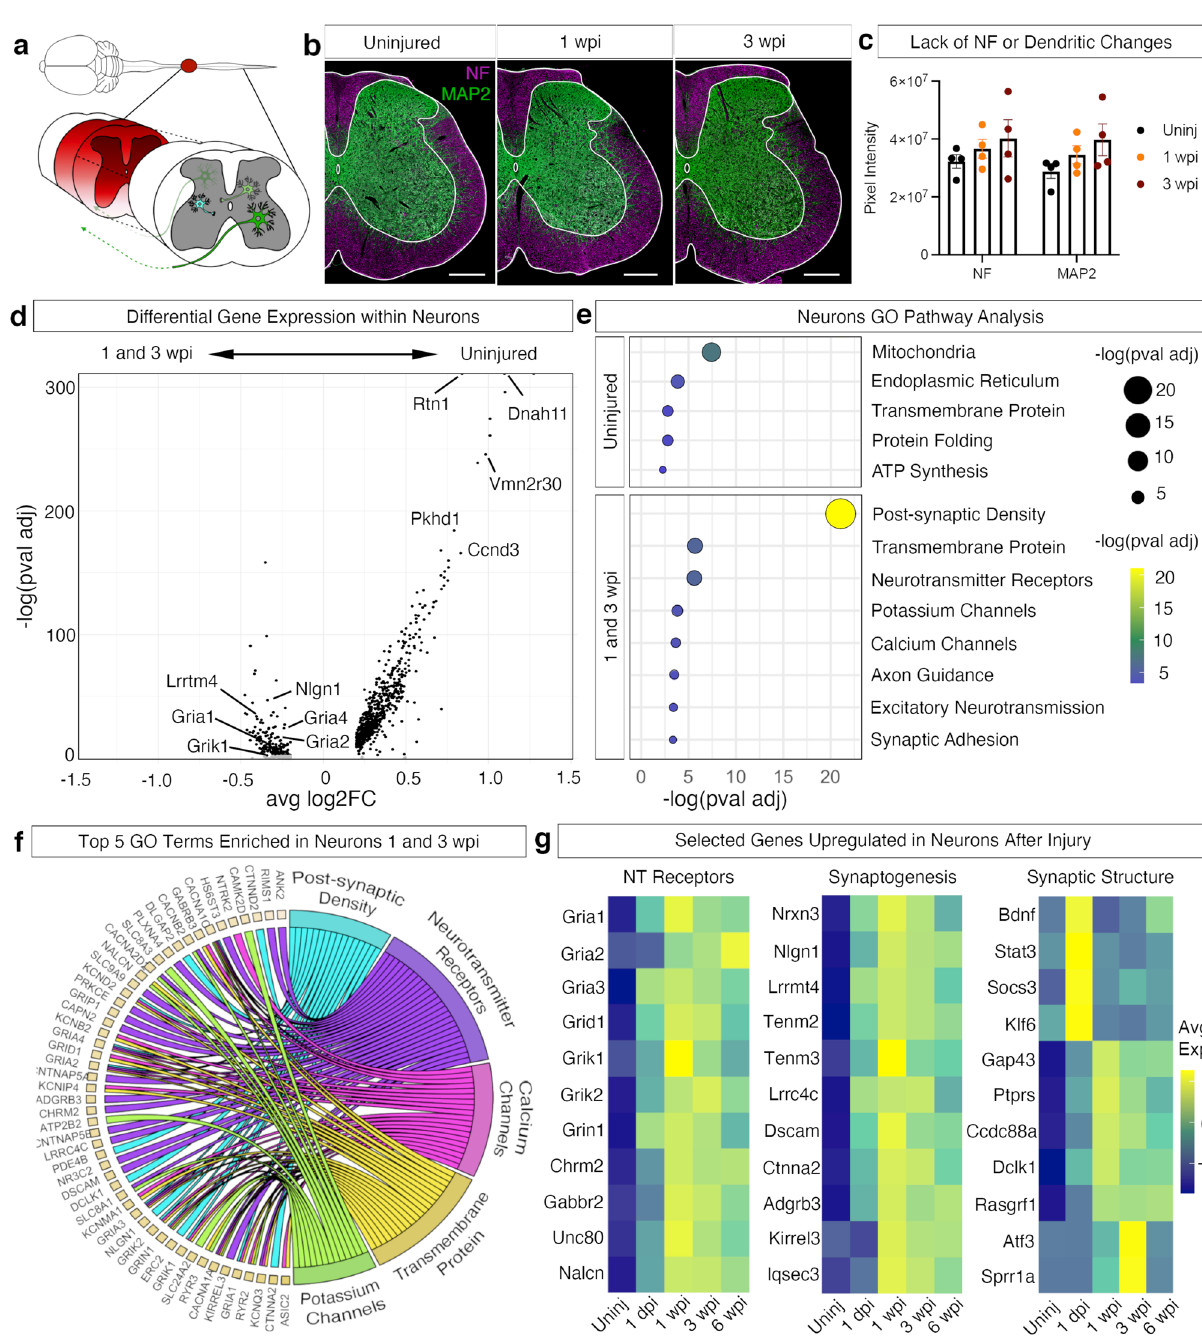
p ≥ 0.001. e Pathway analysis for differentially expressed genes between uninjured and injured time points. X -axis indicates − log( p val adj) of GO and KEGG pathway clusters. P values (adjusted) were calculated using Benjamini – Hochberg false dis- coveryrate(FDR).Yellowindicatesrelativelyhighnormalizedaverageexpressionand dark blue indicates relatively low normalized average expression. f Chord plot indi- cating shared genes between top 5 GO terms from genes upregulated 1 and 3 wpi. g HeatmapsshowingaverageneuronalgeneexpressionfromtopGOterms,including neurotransmitter receptors, synaptogenesis, and synaptic structure. Yellow indicates relatively high normalized average expression (1) and dark blue indicates relatively low normalized average expression ( −